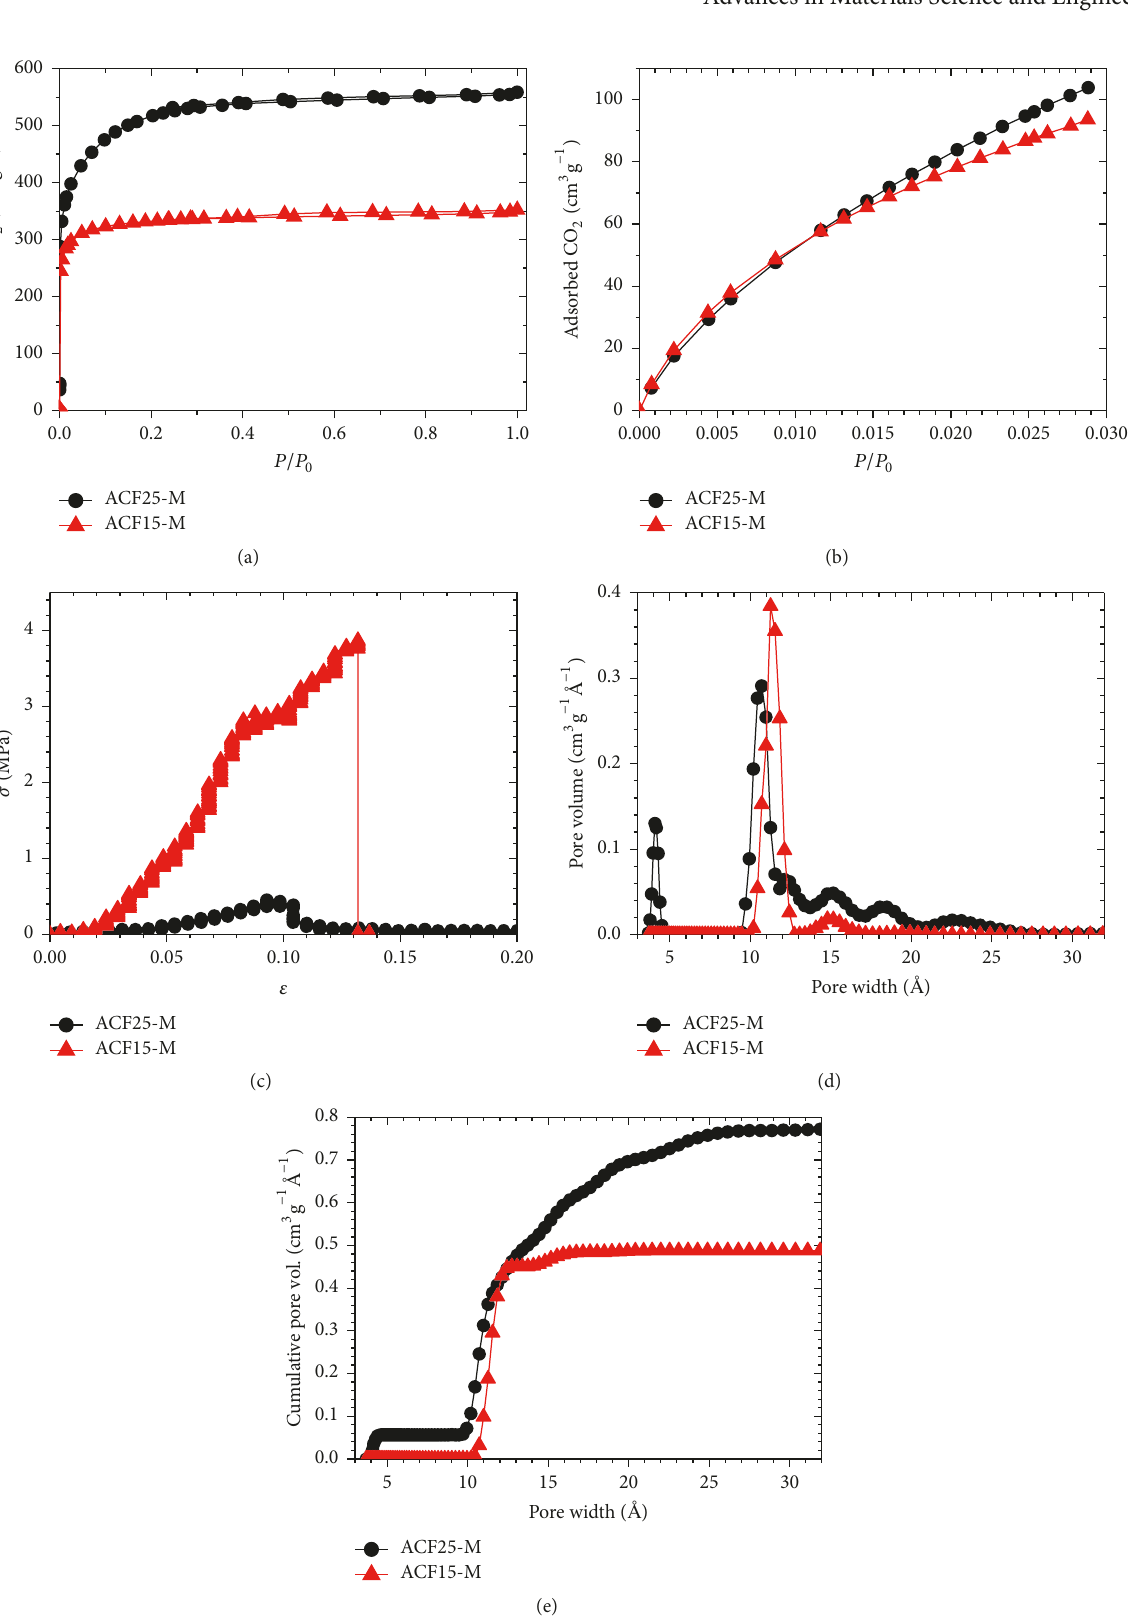
Figure 1: (a) Nitrogen adsorption isotherms obtained at 77 K; (b) carbon dioxide adsorption isotherms obtained at 273 K; (c) mechanical properties from three-point bending tests, represented as stress 𝜎 versus strain 𝜀 ; (d) NLDFT pore size distribution obtained from the N 2 adsorption data; and (e) cumulative pore size